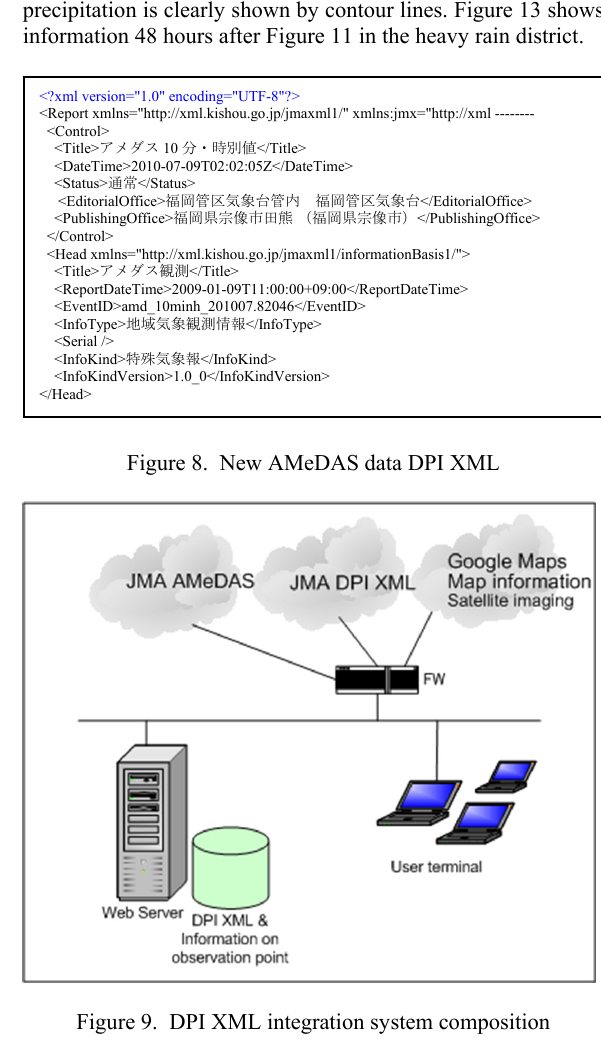
Figure 9. DPI XML integration system composition